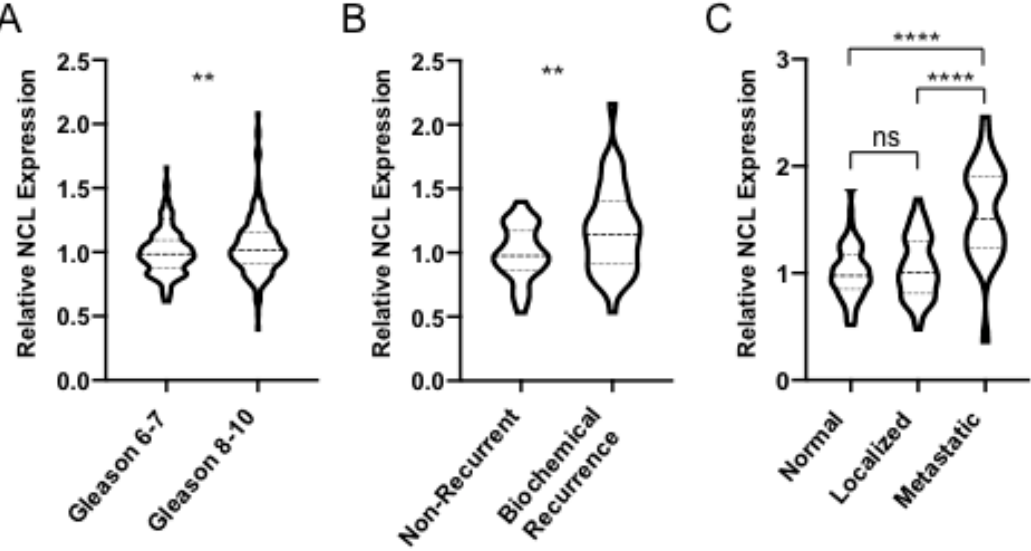
Figure 1. NCL is Upregulated in Aggressive Forms of PCa Violin plots displaying nucleolin (NCL) mRNA expression levels in patient tumor samples stratified by clinical characteristics from ( A ) TCGA provisional database, queried through cBioPortal (Gleason 6 – 7 n = 291; Gleason 8 – 10 n = 206; Pearson: